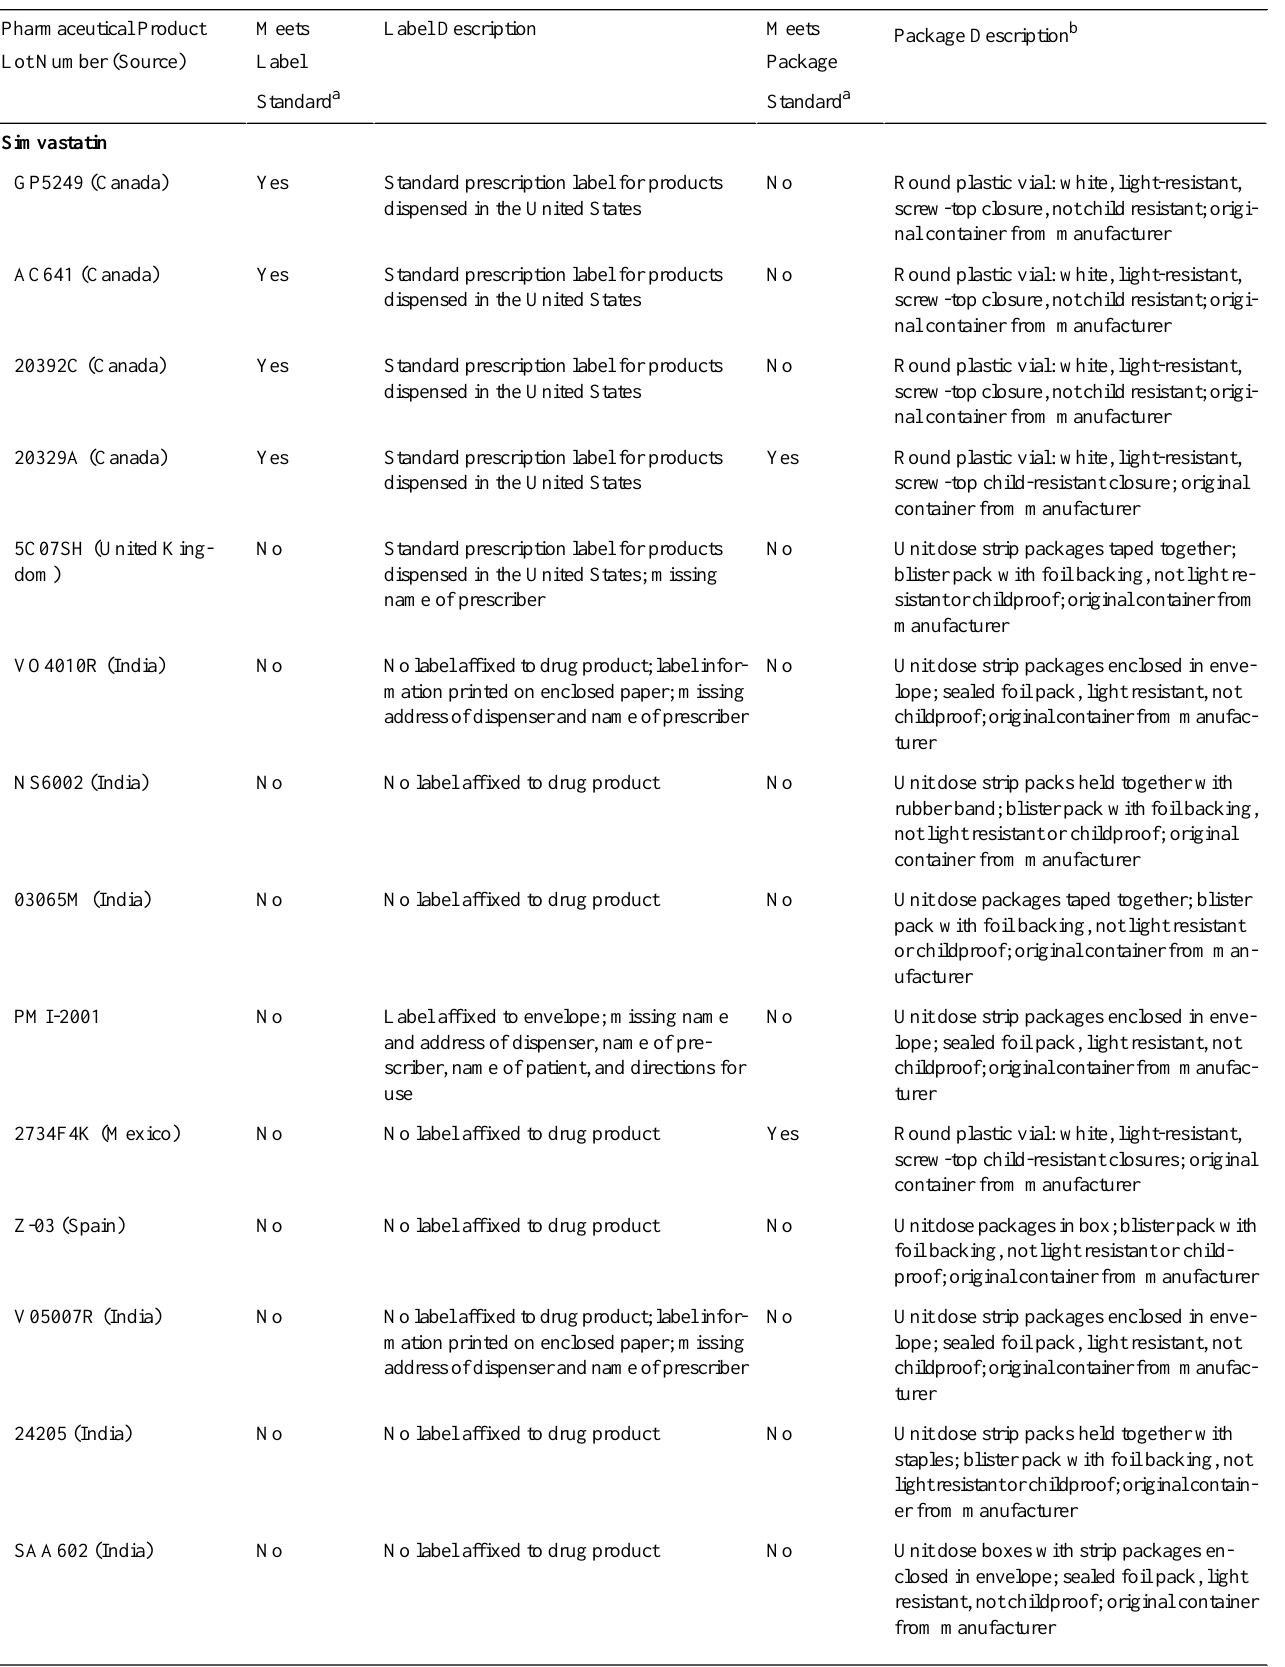
Table 3. Label and package characteristics of pharmaceutical products obtained from the